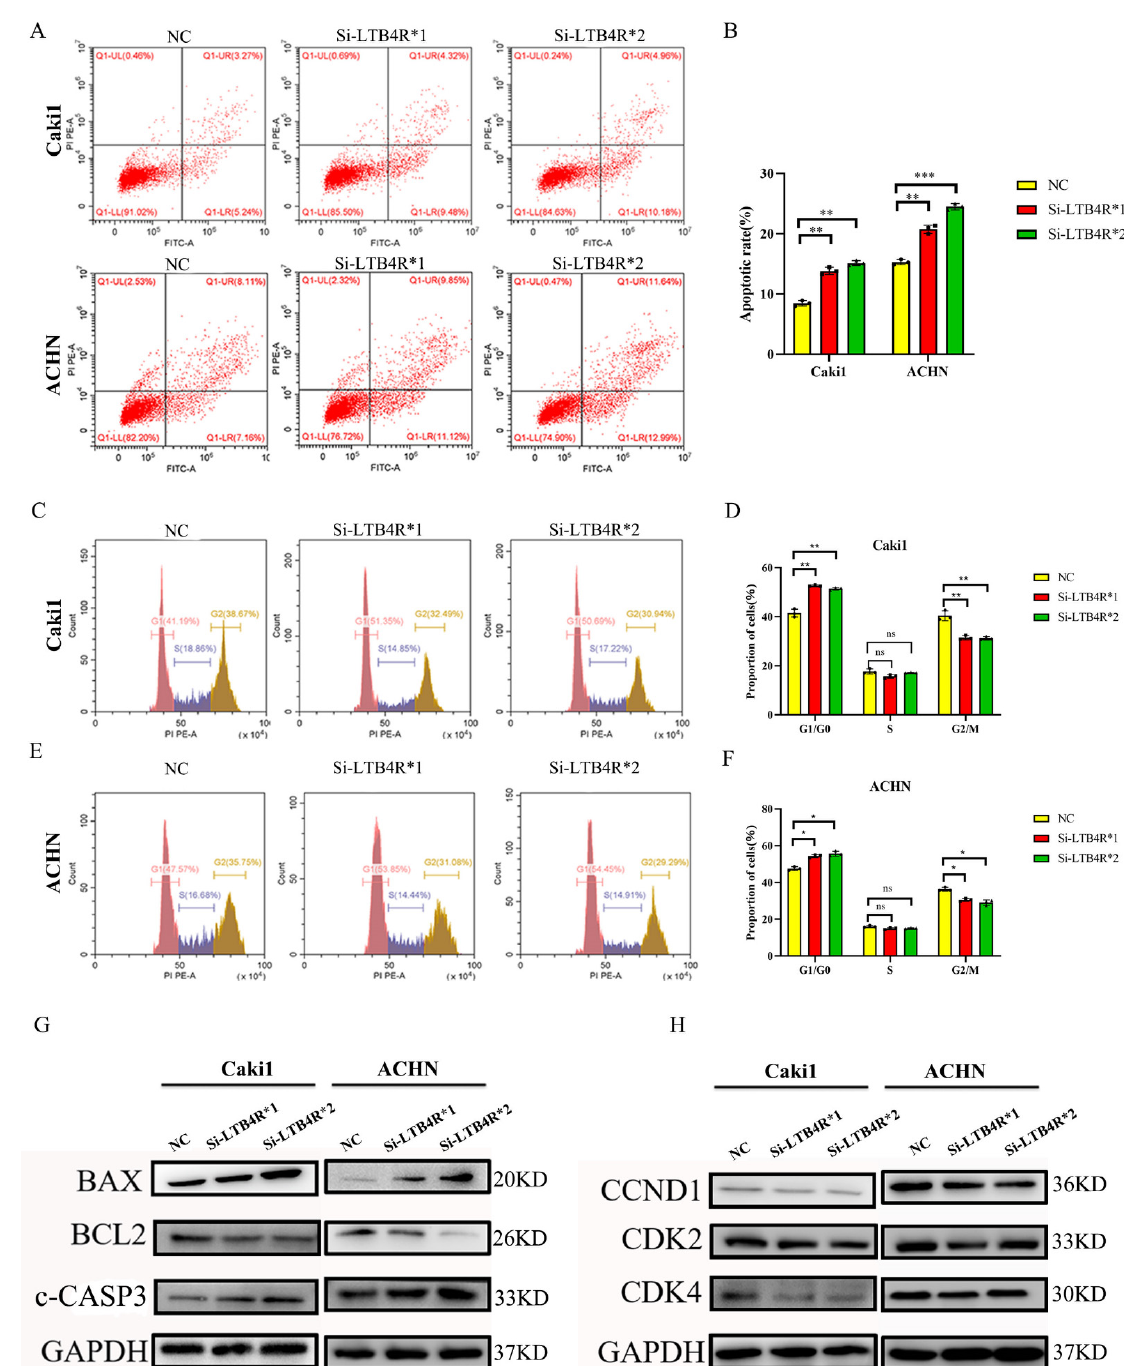
Figure 2. Interfering with LTB4R inhibited ccRCC cell cycle and promoted ccRCC cell apoptosis. ( A , B ) Knockdown of LTB4R promoted apoptosis in Caki1 and ACHN cells. ( C – F ) After knockdown of LTB4R, the proportion of the G1/G0 phase in Caki1 and ACHN cells increased, while the proportion of the G2/M phase decreased, and the proportion of the S phase did not change significantly. ( G ) Western Blot Analysis showed that after knockdown of LTB4R, the apoptosis-related proteins, BAX and c-CASP3 (c-caspase-3) were increased and the anti-apoptotic protein BCL2 was decreased in Caki1 and ACHN cells. ( H ) Western Blot Analysis showed that the period-related proteins CCND1 (CyclinD1), CDK2, and CDK4 were all reduced after LTB4R knockdown. A 2-tailed t test was used (* p < 0.05; ** p < 0.01, *** p < 0.001, ns, not